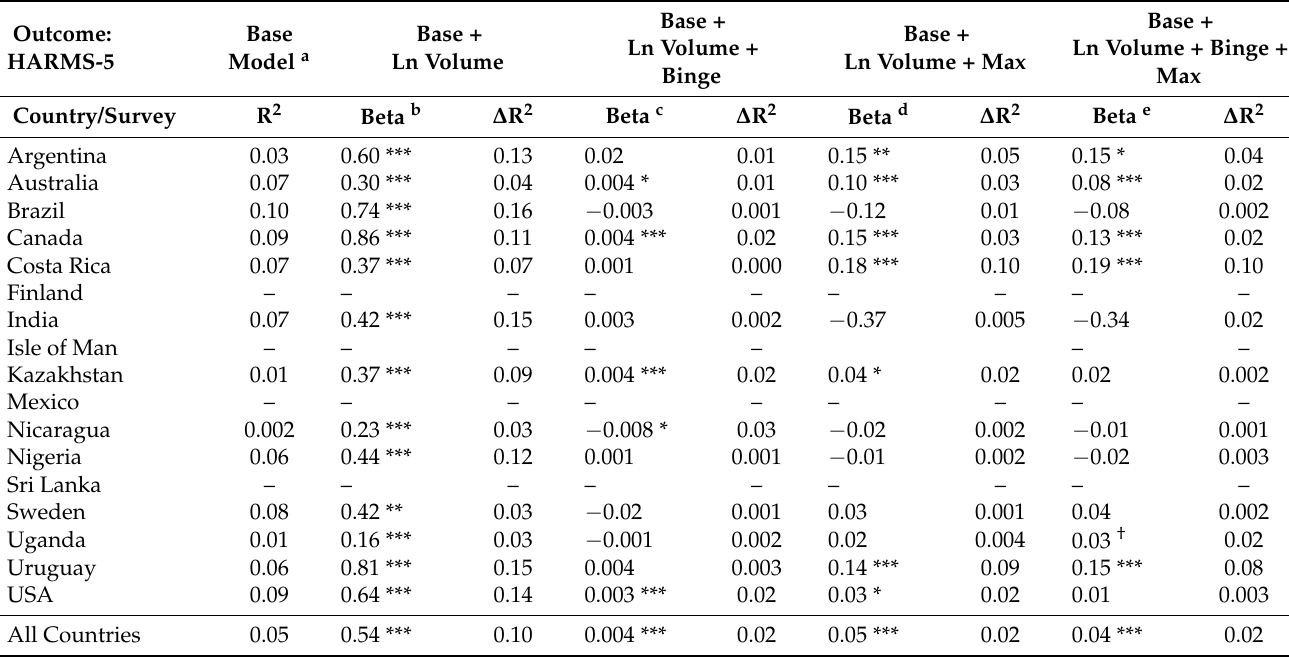
Table 7. Female Regressions Predicting